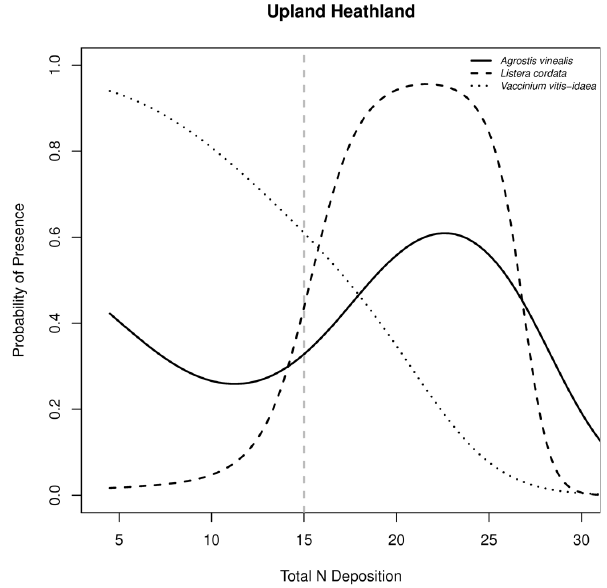
Fig. 6. Change in probability of presence for species showing sta- tistically significant relationships to N deposition in upland heath- land in the BSBI local change survey data against increasing to- tal inorganic N deposition (kgNha − 1 yr − 1 ) . The dashed grey line indicates the midpoint of the critical load range for heathlands as defined by Bobbink and Hettelingh